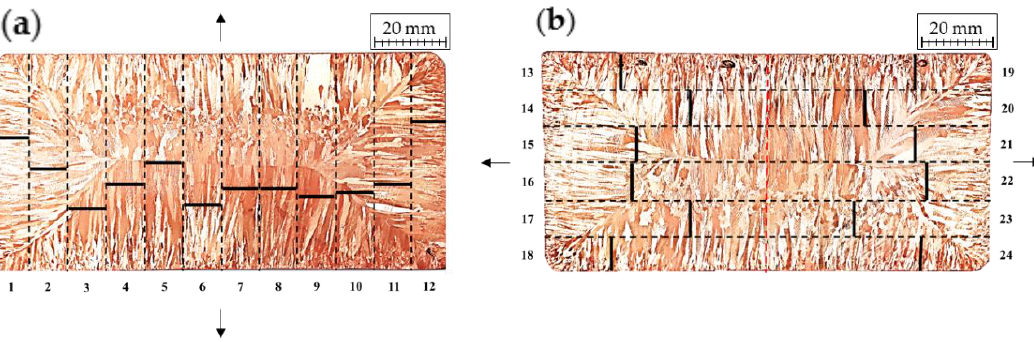
Figure 6. The places were fractures in uniaxial tensile test occurred, where ( a ) the tensile force is parallel to the height of the strand, ( b ) the tensile force is perpendicular to the height of the strand. Only one of the tested samples ruptured at the crystallization front (sample marked as 5). Prior to